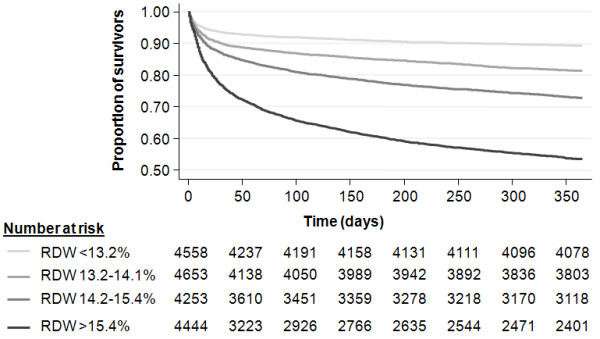
Kaplan-Meier plot for 1-year survival within RDW quartiles (< 13.2%, 13.2% to 14.1%, 14.1% to 15.4%, and > 15.4%).